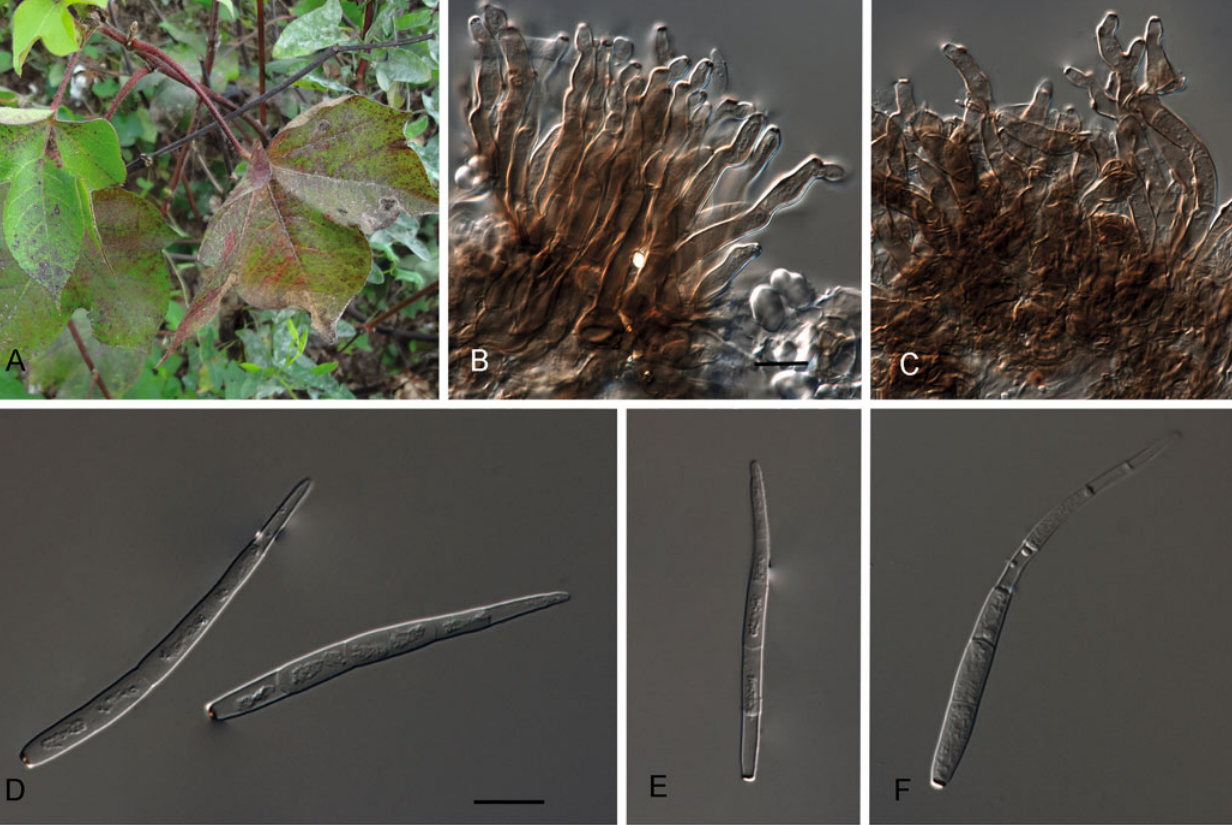
Fig. 8. Cercospora (cid:19)(cid:26)(cid:28) gossypii (cid:24)%’7(cid:2)!.$!.#(cid:27)(cid:28)(cid:2) A. (cid:2)S(cid:13)(cid:9)(cid:26)(cid:2)(cid:7)(cid:18)(cid:4)(cid:8)(cid:7)(cid:28)(cid:2) B–C. (cid:2)2(cid:9)(cid:7)(cid:19)(cid:11)(cid:19)(cid:5)(cid:23)(cid:9)(cid:8)(cid:13)(cid:2)(cid:19)(cid:4)(cid:17)(cid:11)(cid:21)(cid:11)(cid:4)(cid:18)(cid:14)(cid:4)(cid:10)(cid:13)(cid:7)(cid:28)(cid:2) D–F